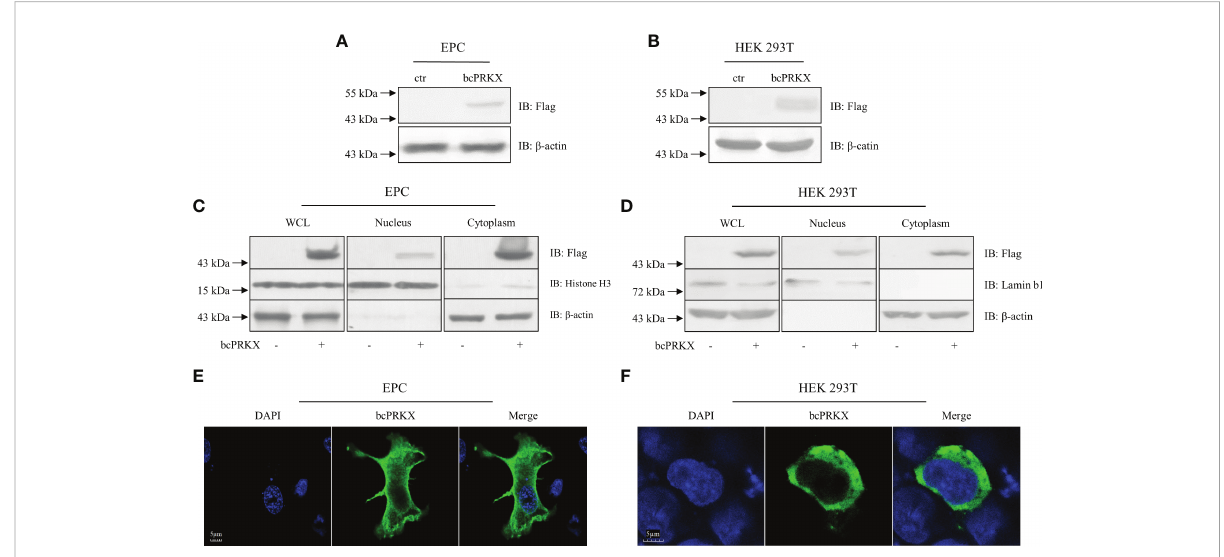
FIGURE 4 The subcellular distribution of bcPRKX. (A, B) EPC or HEK 293T cells in 6-well plates were transfected with bcPRKX. The cells were harvested and lysed for immunoblotting (IB) at 48 h post-transfection. (C, D) EPC or HEK 293T cells in 6 cm diameter petri dish were transfected with bcPRKX and subjected to subcellular fraction assay at 48 h post-transfection. The whole cell lysate (WCL), nuclear extract and cytosolic extract were made separately according to the methods. IB for Histone H3 and Lamin b1 were used for nuclear internal reference of EPC and HEK 293T cells respectively; IB for b -actin was used for cytosolic internal reference. (E, F) EPC or HEK 293T cells in 24-well plates were transfected with bcPRKX and cells were subjected to immuno fl uorescence microscopy at 24 h post-transfection. The scale bar represented 5 m m. bcPRKX: